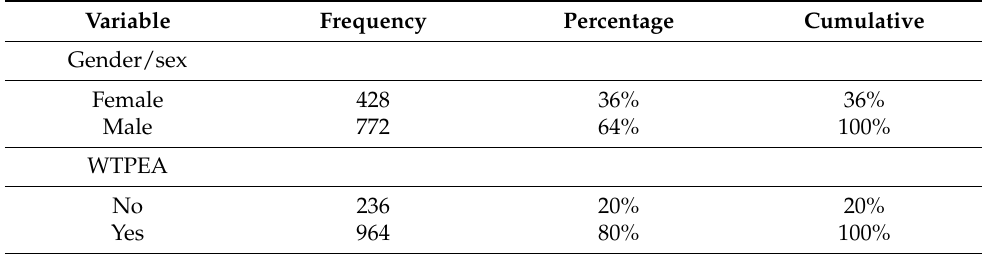
Table 3. Frequency distribution of the study